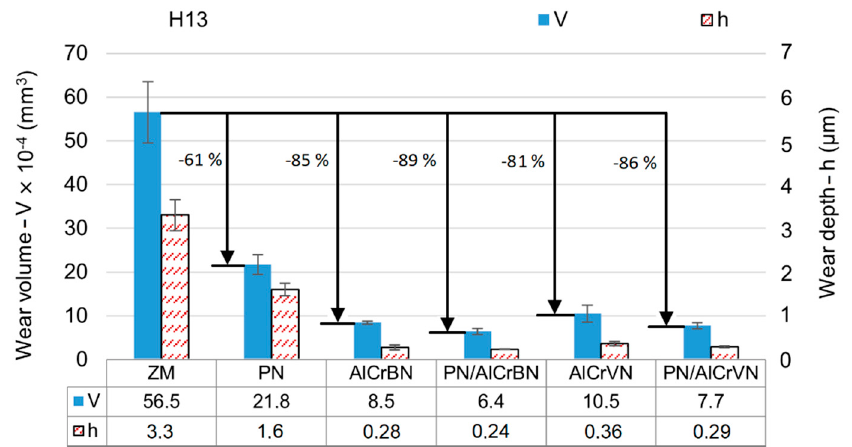
Figure 16. Wear volumes and wear depth of the tested materials of steel H13.